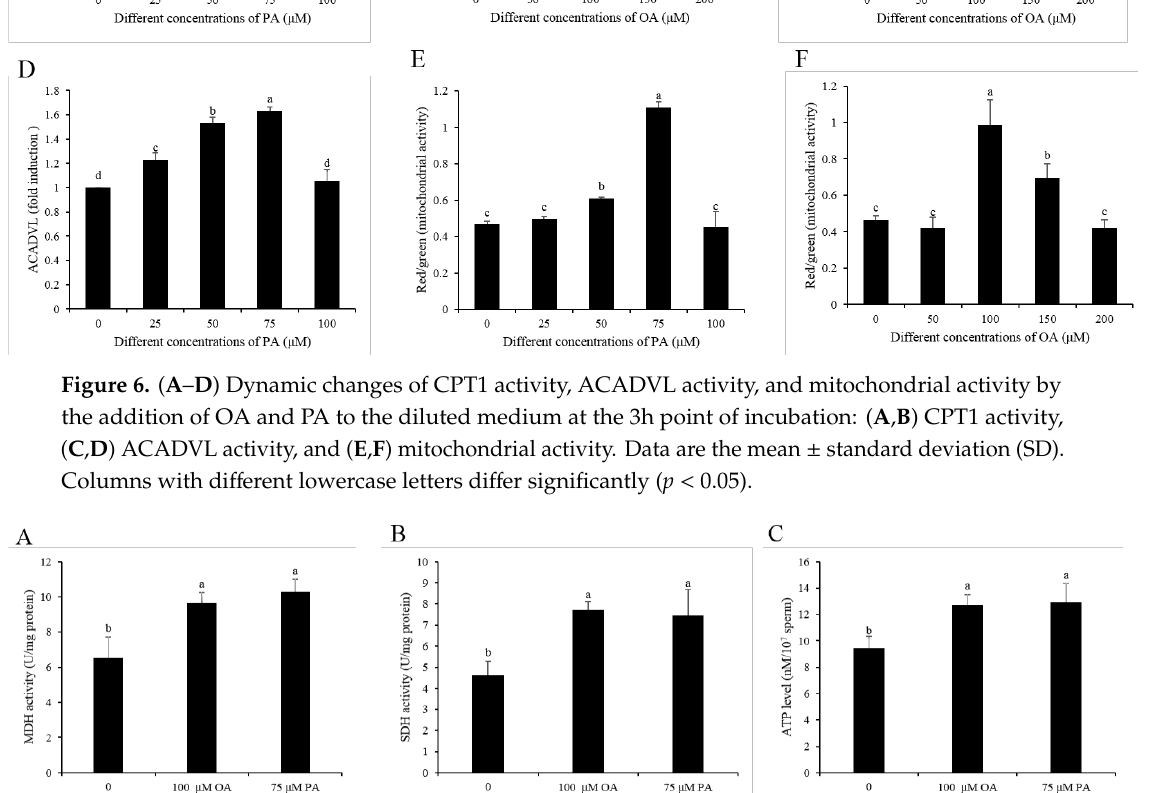
Figure 7. Addition of OA and PA increased sperm MDH activity (A), SDH activity (B), and ATP level (C) after 3h of incubation. Data are the mean ± standard deviation (SD). Columns with different lowercase letters differ significantly ( p ＜ 0.05). MDH: malate dehydrogenase. SDH: succinate dehydrogenase.